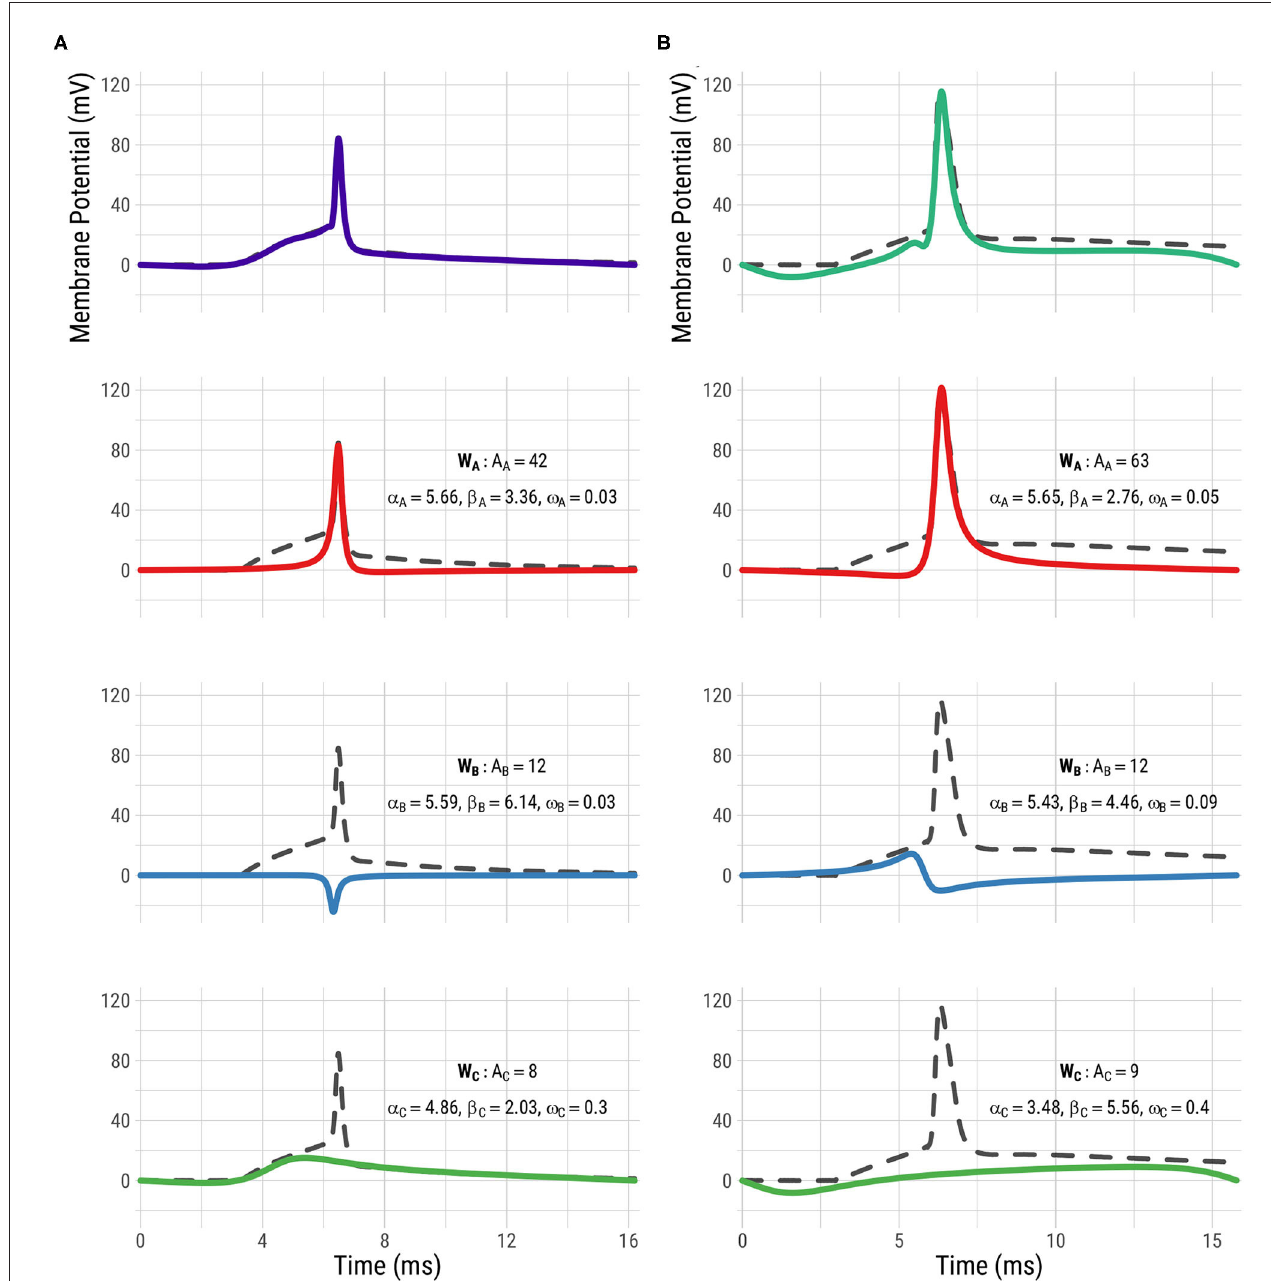
FIGURE 1 | FMM analysis of postsynaptic APs from GABAergic and glutamatergic neurons. First row: FMM prediction (solid line) and observed signal (dashed line) of postsynaptic APs from a GABAergic neuron (A) and a glutamatergic neuron (B) . Rows 2 − 4: Models’ corresponding wave decomposition ( W A in red, W B in blue and W C in green) along with their